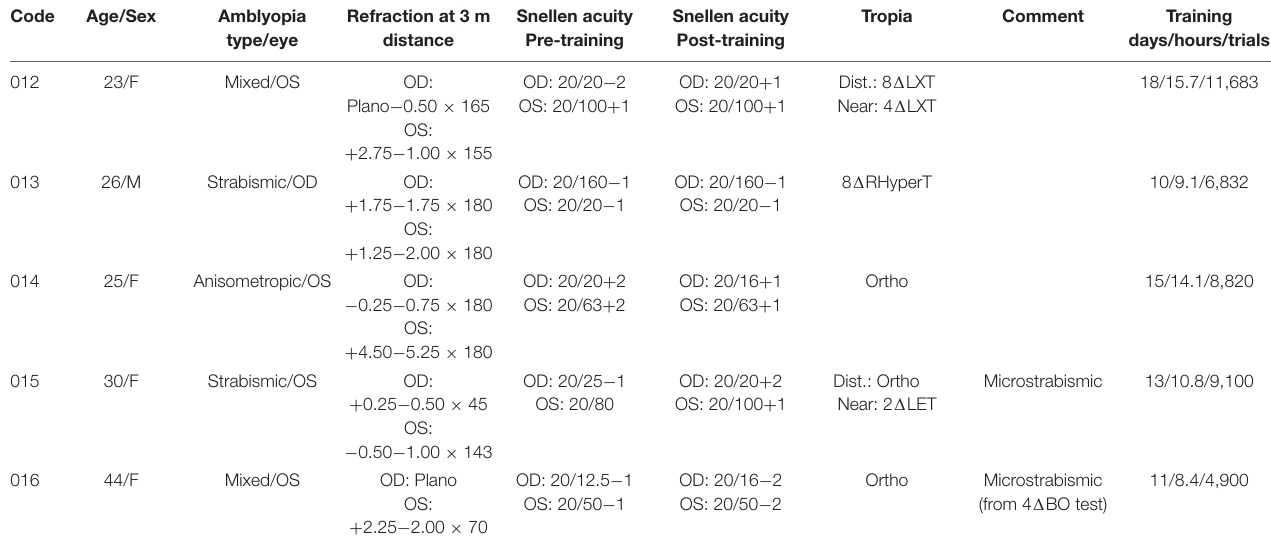
TABLE 1 | Participant’s clinical